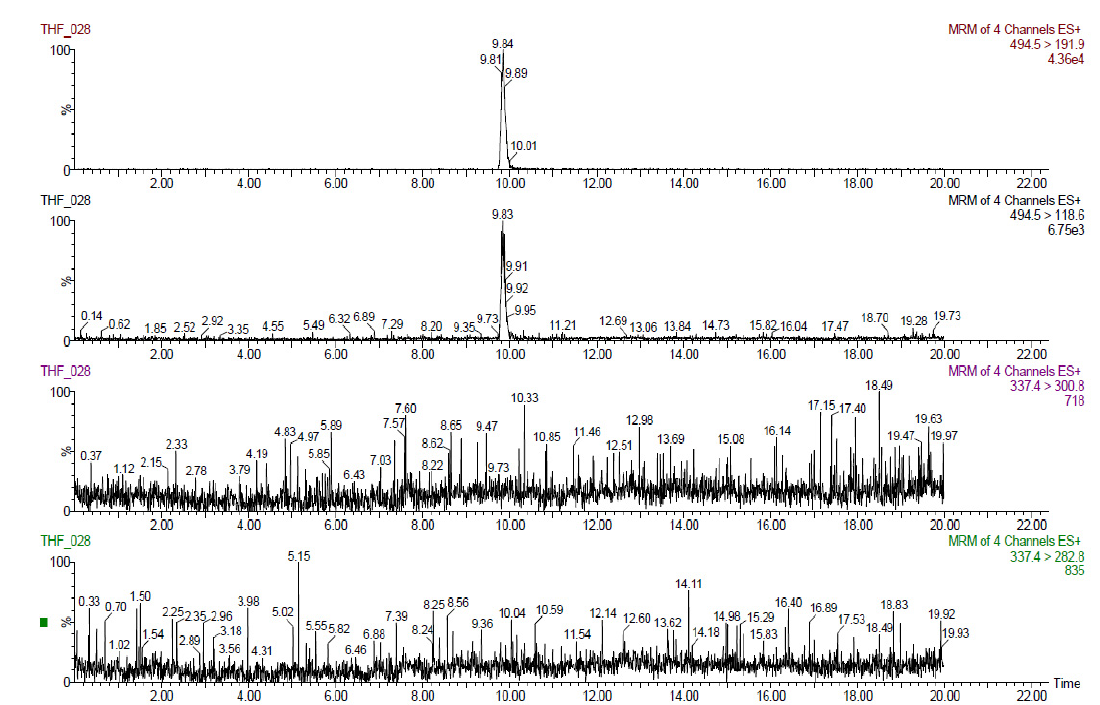
Figure A1. Chromatogram of a muscle sample fortified with tiamulin at 25 μ g/kg.